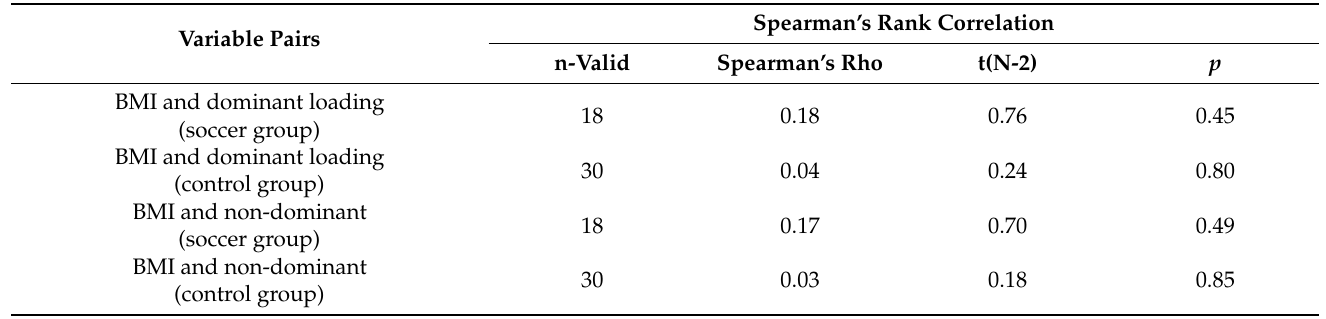
Table 4. Spearman’s rank correlation coefficients of BMI (body mass index) and load in the dominant and non-dominant limbs in the static test in both study groups.